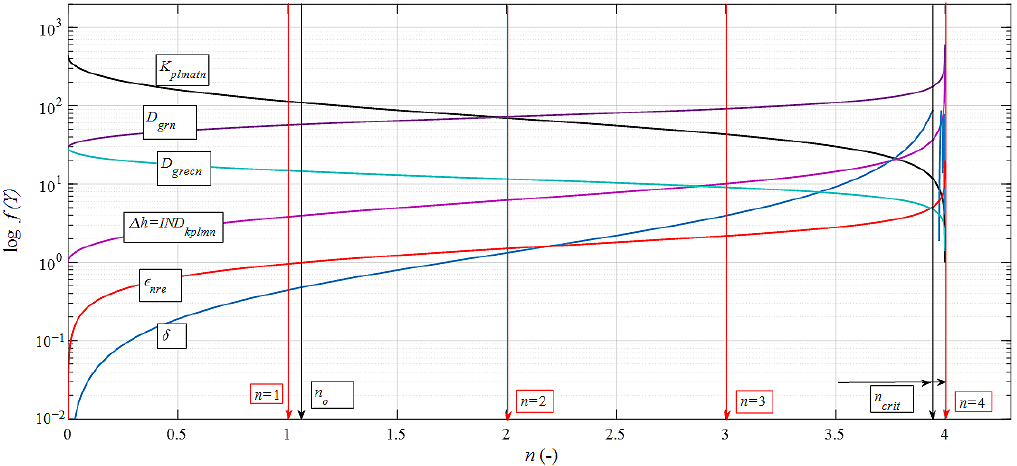
Figure 16. Logarithmic dependence of prediction functions on the number of extrusions.